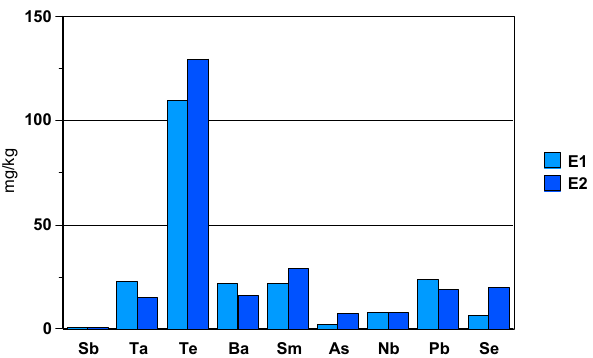
Figure 19. Concentration of trace elements [mg / kg] found in solution.